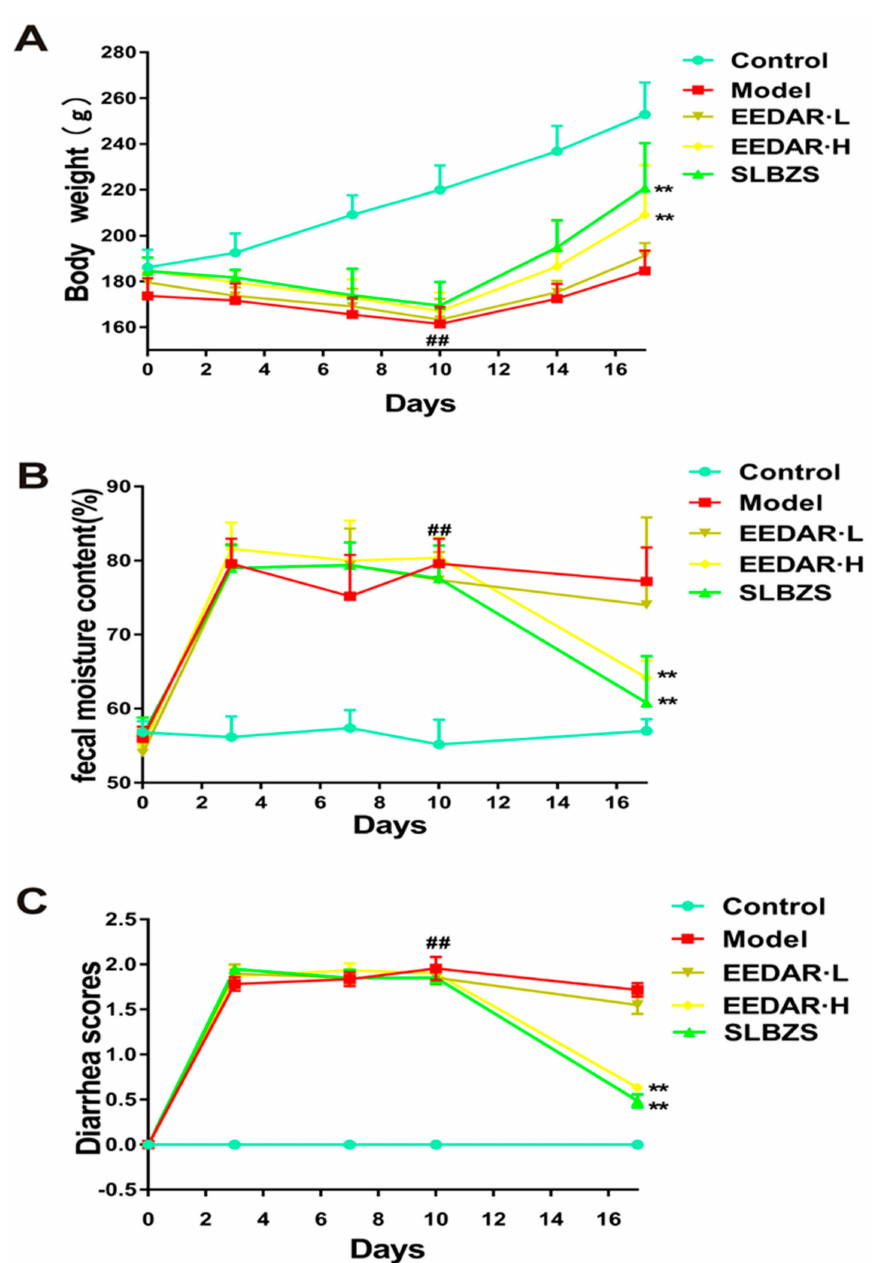
Figure 1. E ff ect of EEDAR on body weight, diarrhea scores, and fecal moisture content in spleen deficiency diarrhea rats ( n = 10). Body weight ( A ), diarrhea scores ( B ), and fecal moisture content ( C ) changed daily during the experiment. Values are expressed as means ± SEM. ## p < 0.01 vs. Control; ** p < 0.01 vs.